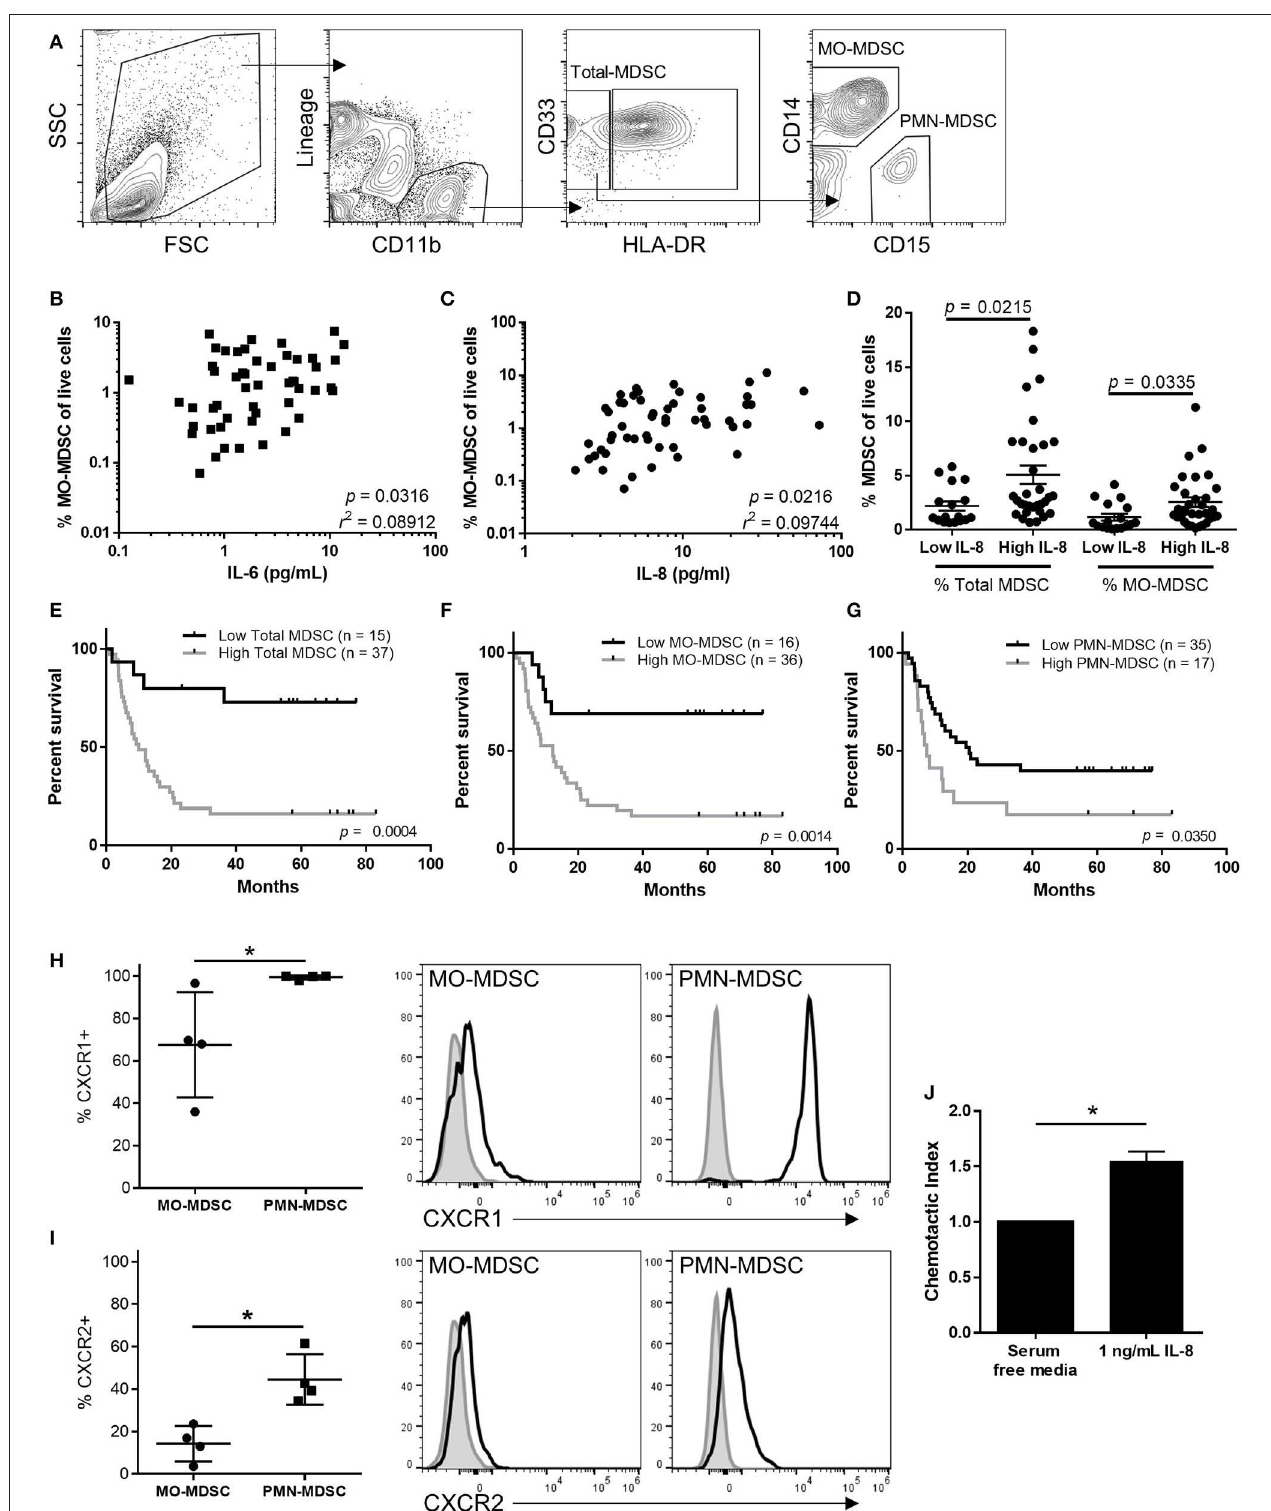
FIGURE 3 | MDSCs correlate with survival and are increased in the circulation of patients with high levels of IL-8. (A) Representative flow cytometric analysis of MDSCs in the peripheral blood of stage IV melanoma patients. Correlation of MO-MDSCs with circulating concentrations of IL-6 (B) or IL-8 (C) . (D) The frequency